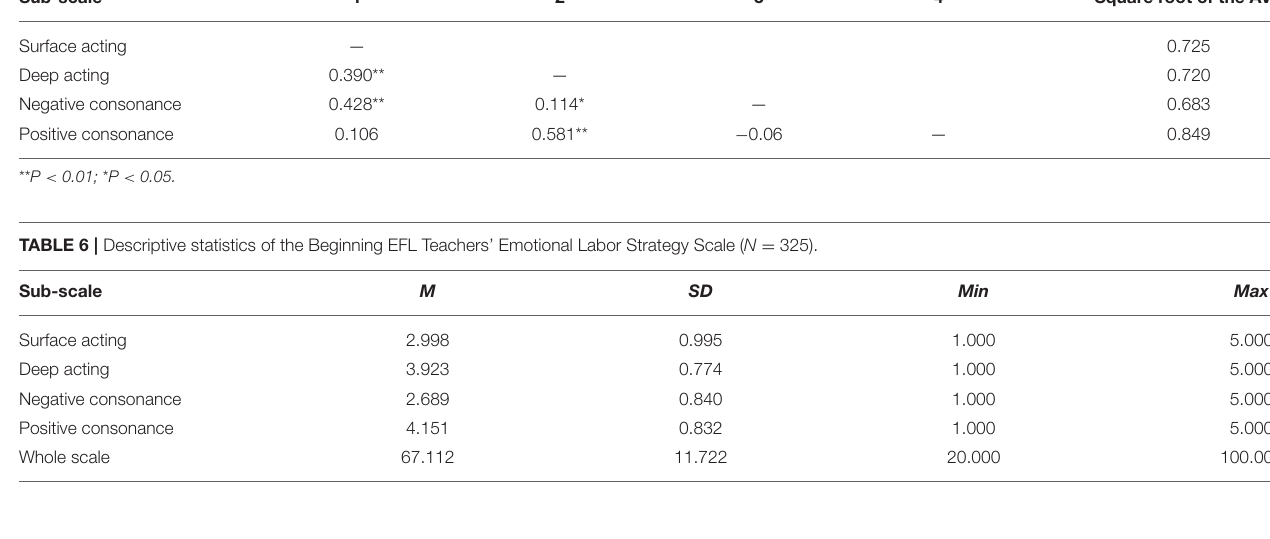
TABLE 5 | Discriminant validity of each sub-scale of the Beginning EFL Teachers’ Emotional Labor Strategy Scale. Sub-scale